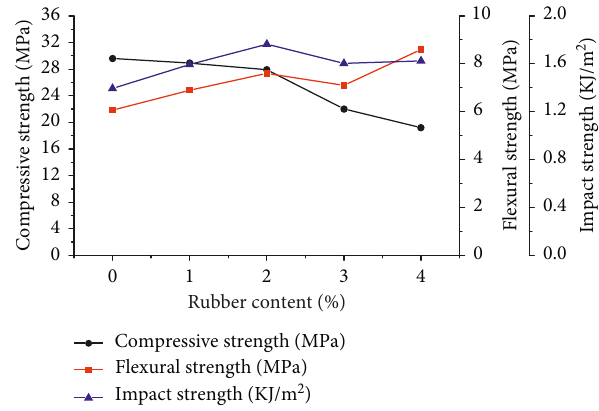
Figure 6: Dependence of rubber content on mechanical properties of cement slurry. Table 4: Rheological properties of cement slurry with rubber and latex.